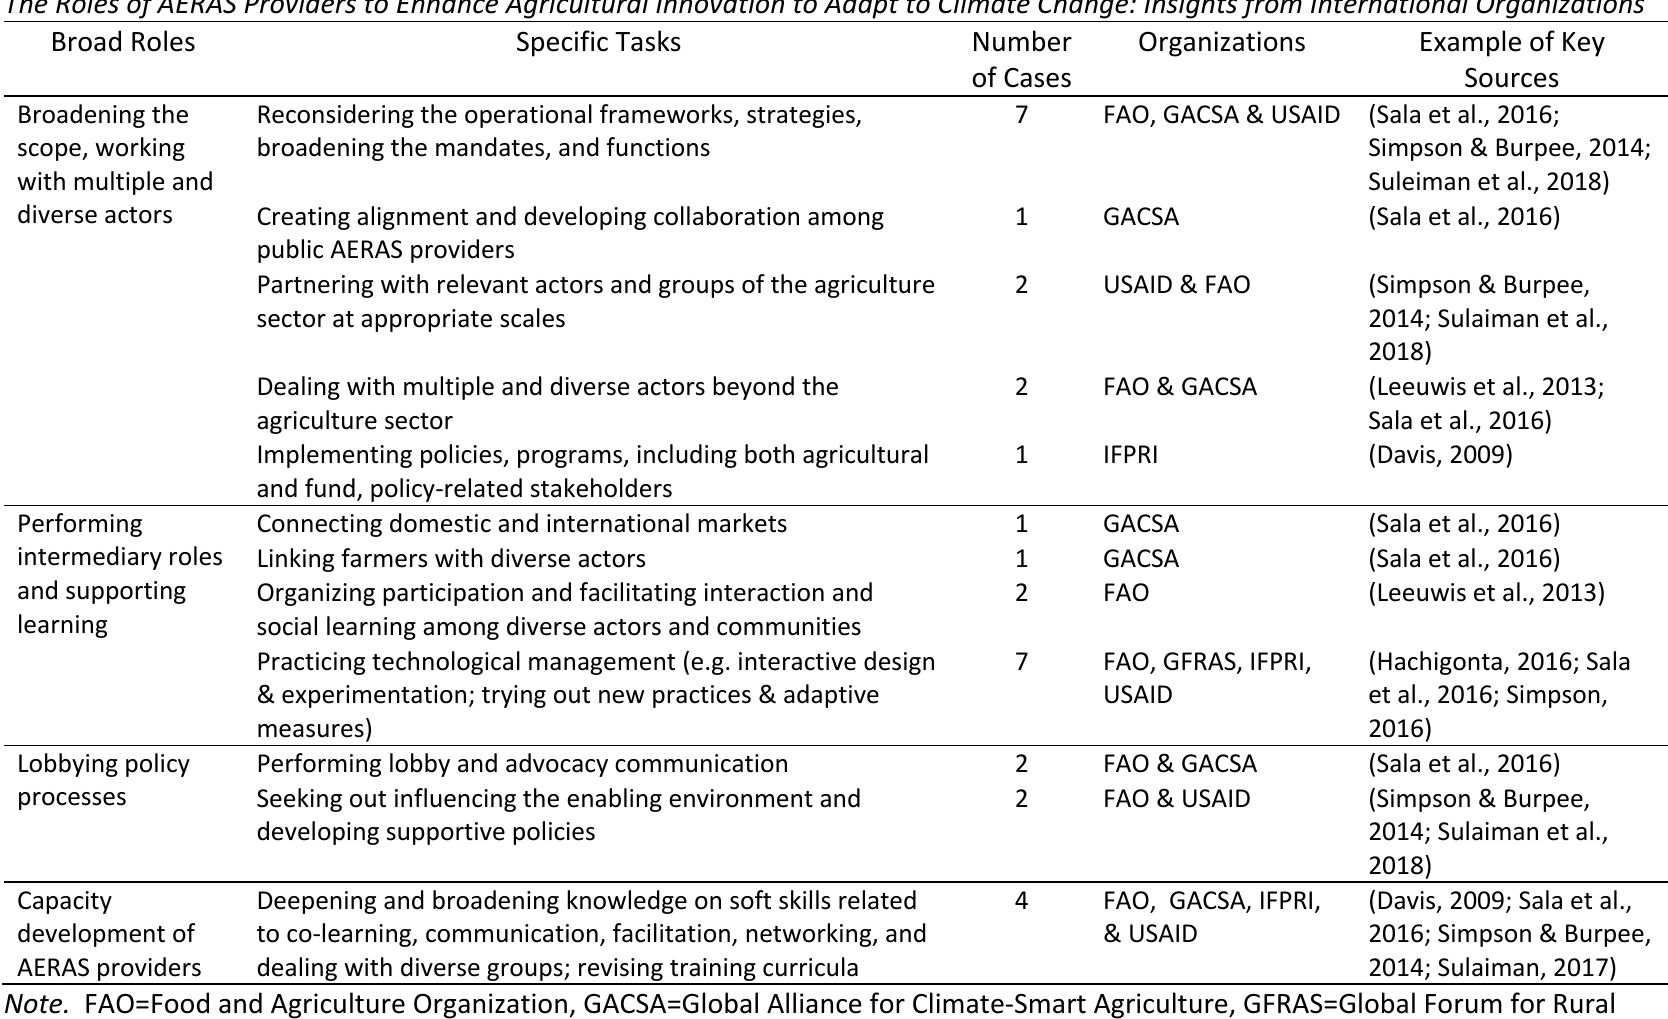
Table 1 The Roles of AERAS Providers to Enhance Agricultural Innovation to Adapt to Climate Change: Insights from International Organizations Broad